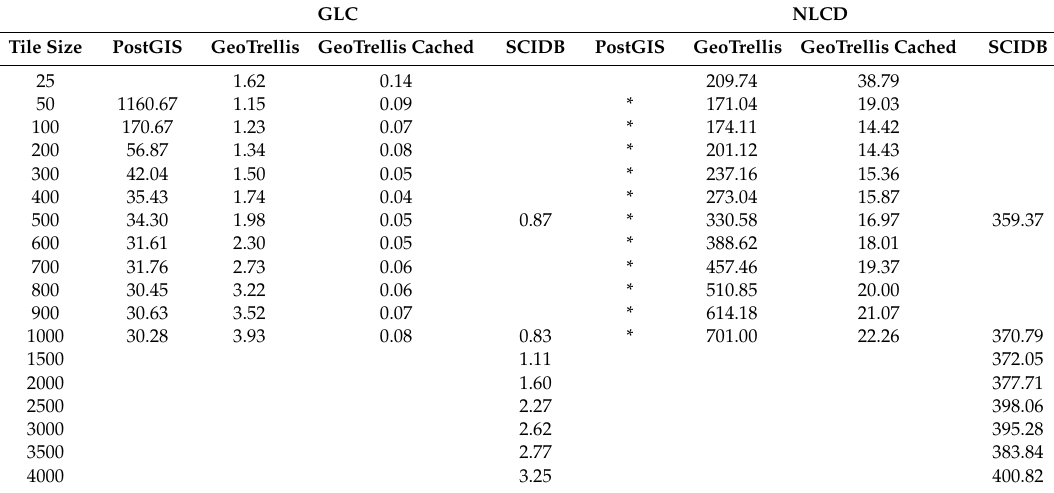
Table 7. Raster add performance times in seconds on for GLC and NLCD